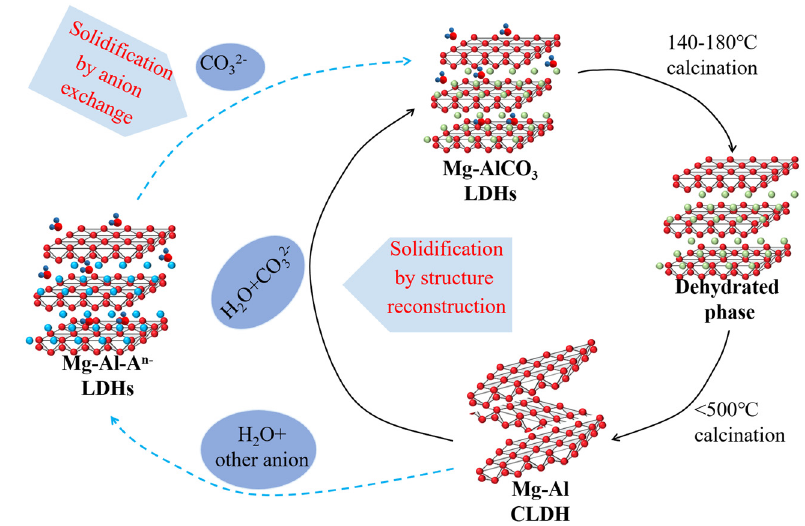
Figure 5: Process of thermal decomposition, structural reconstruction, and CO 32− binding process of